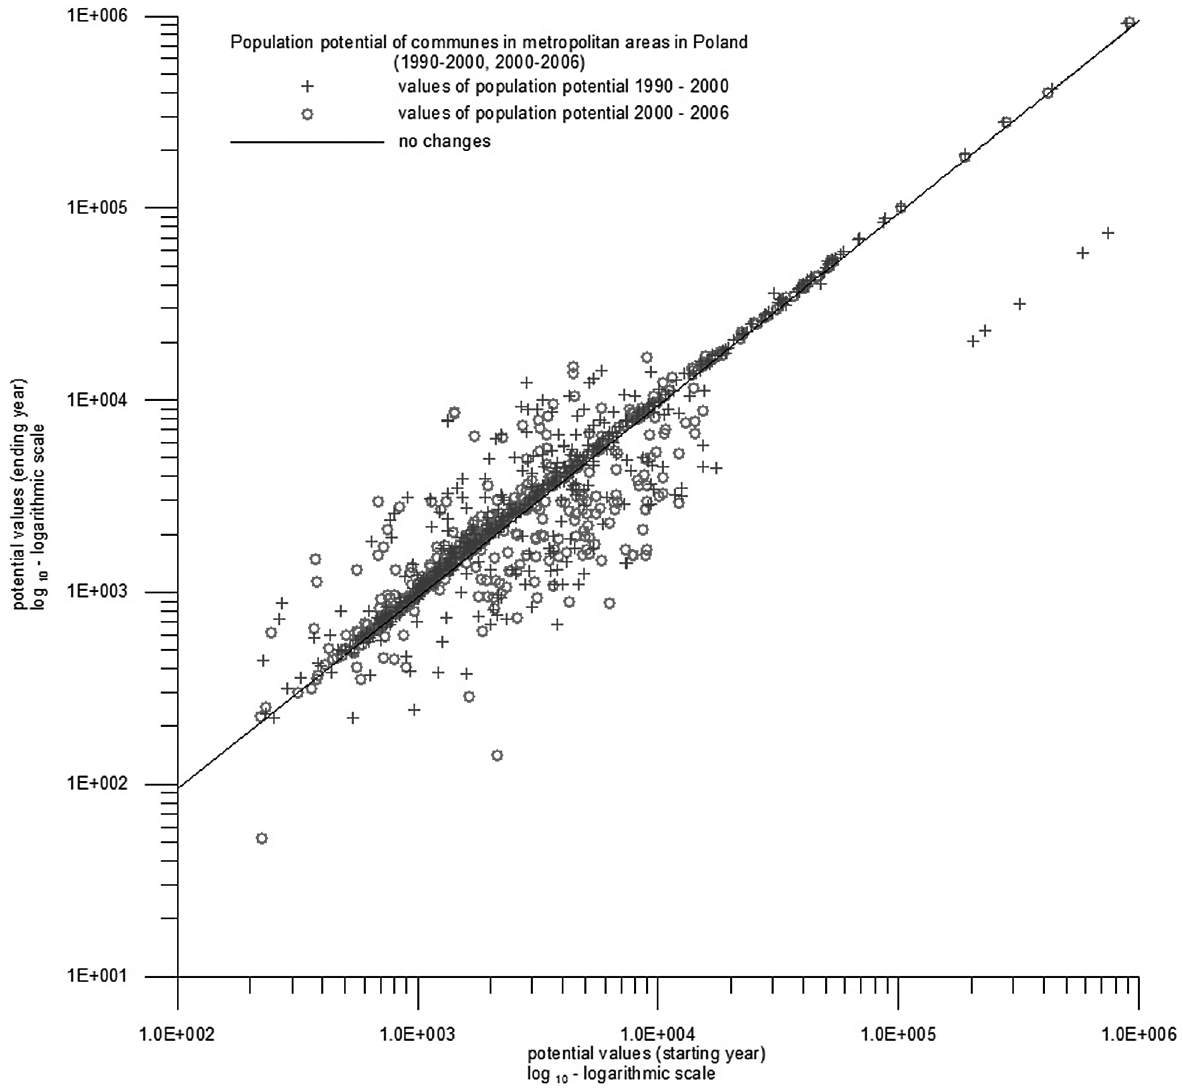
Fig. 3. Population potential by municipalities of the metropolitan areas in Poland